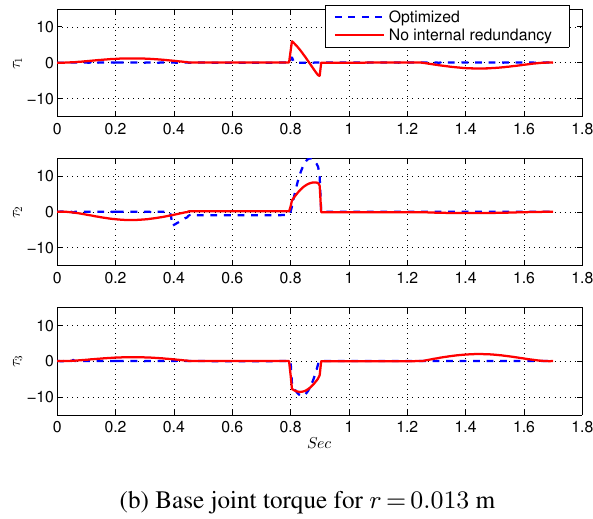
Fig. 5: The torques of the ground actuators (in N.m) and displacement of the portable masses (in m) for r = 0 . 025 m and λ = 0 . 5 .